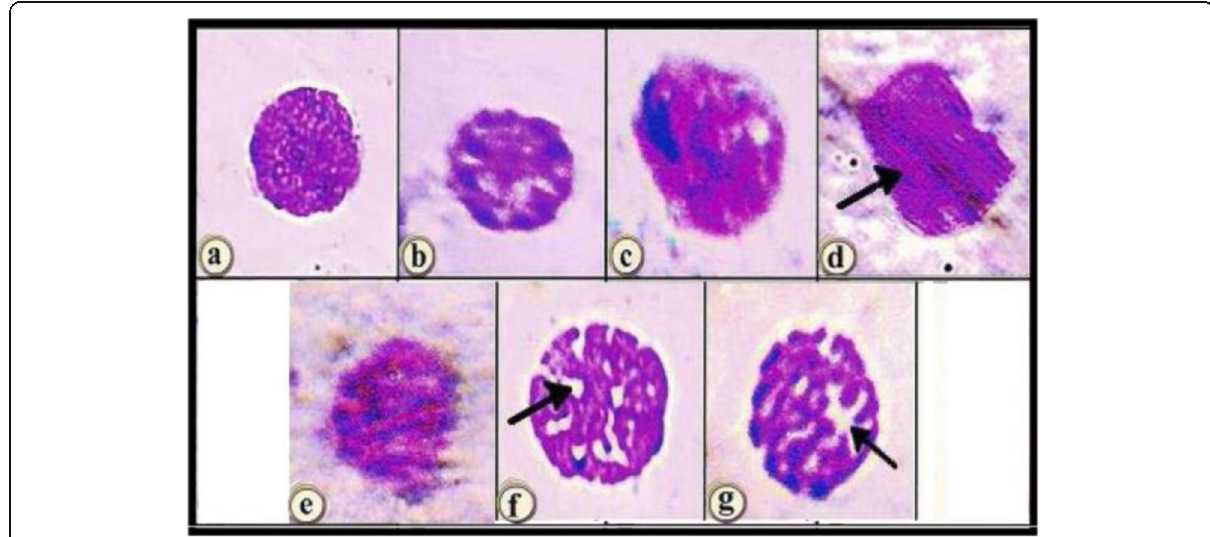
Fig. 6 Morphological changes in spherule cells ( x = 1600). a Normal cells: round with undistinguished nucleus b 40 Gy and c 100 Gy: increased the cell size. d BA2 20 IJs/ml induced cytoplasmic vacuolation (arrow) and e BA2 40 IJs/ml: irregular shape of the sphere cell. f 40 Gy + BA2 20 IJs/ml and g 40 Gy + BA2 40 IJs/ml: increased the cell size with cytoplasm vacuolation